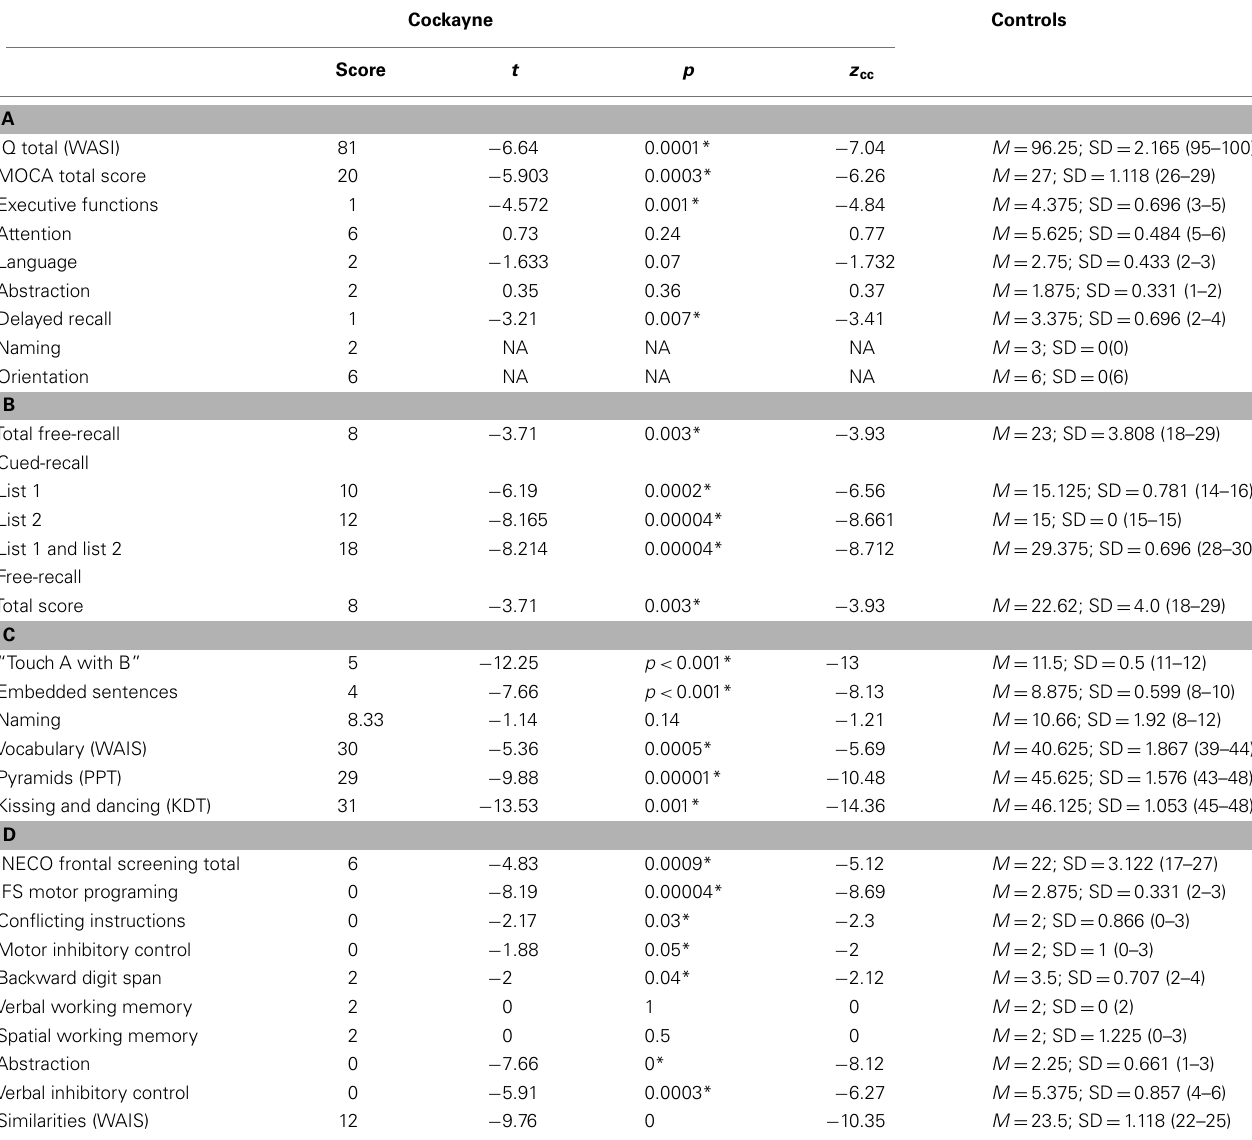
Table 1 | (A) Estimative intellectual level and general cognitive state, (B) memory capacity test, (C) language, and (D) executive functions